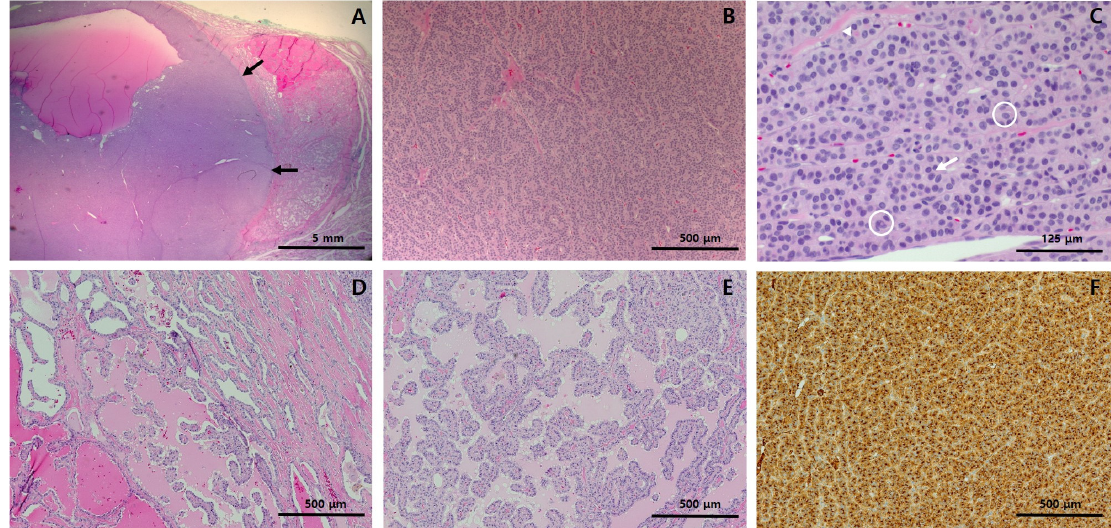
Figure 2. Histological features and immunohistochemistry results of the right thyroid lobectomy specimen. ( A ) At low- power view, the solid portion (black arrows) constitutes more than half of the tumor; ( B ) At medium-power view, the solid portion showed trabecular and insular growth patterns; ( C ) At high-power view, the solid portion was found to be predominantly composed of uniform cells with abundant pale eosinophilic cytoplasm. They also had nuclear features characteristic of papillary carcinoma, including pseudoinclusions (circle) nuclear grooves (arrow), and irregular nuclear contour (arrow head). ( D , E ) The tumor area surrounding the solid portion showed highly irregular follicles, many of which have papillary infoldings and colloid scalloping. The tumor cells showed typical papillary carcinoma nuclear features. ( F ) Immunohistochemically, the tumor cells were positive for thyroglobulin, indicating thyroid origin. Staining method: ( A – E ), hematoxylin and eosin; (F), polymer method. Original magnification: ( A ), ×10; ( B ), ×100, ( C ), ×400; ( D ), ×100; ( E ), ×100; ( F ), ×100.